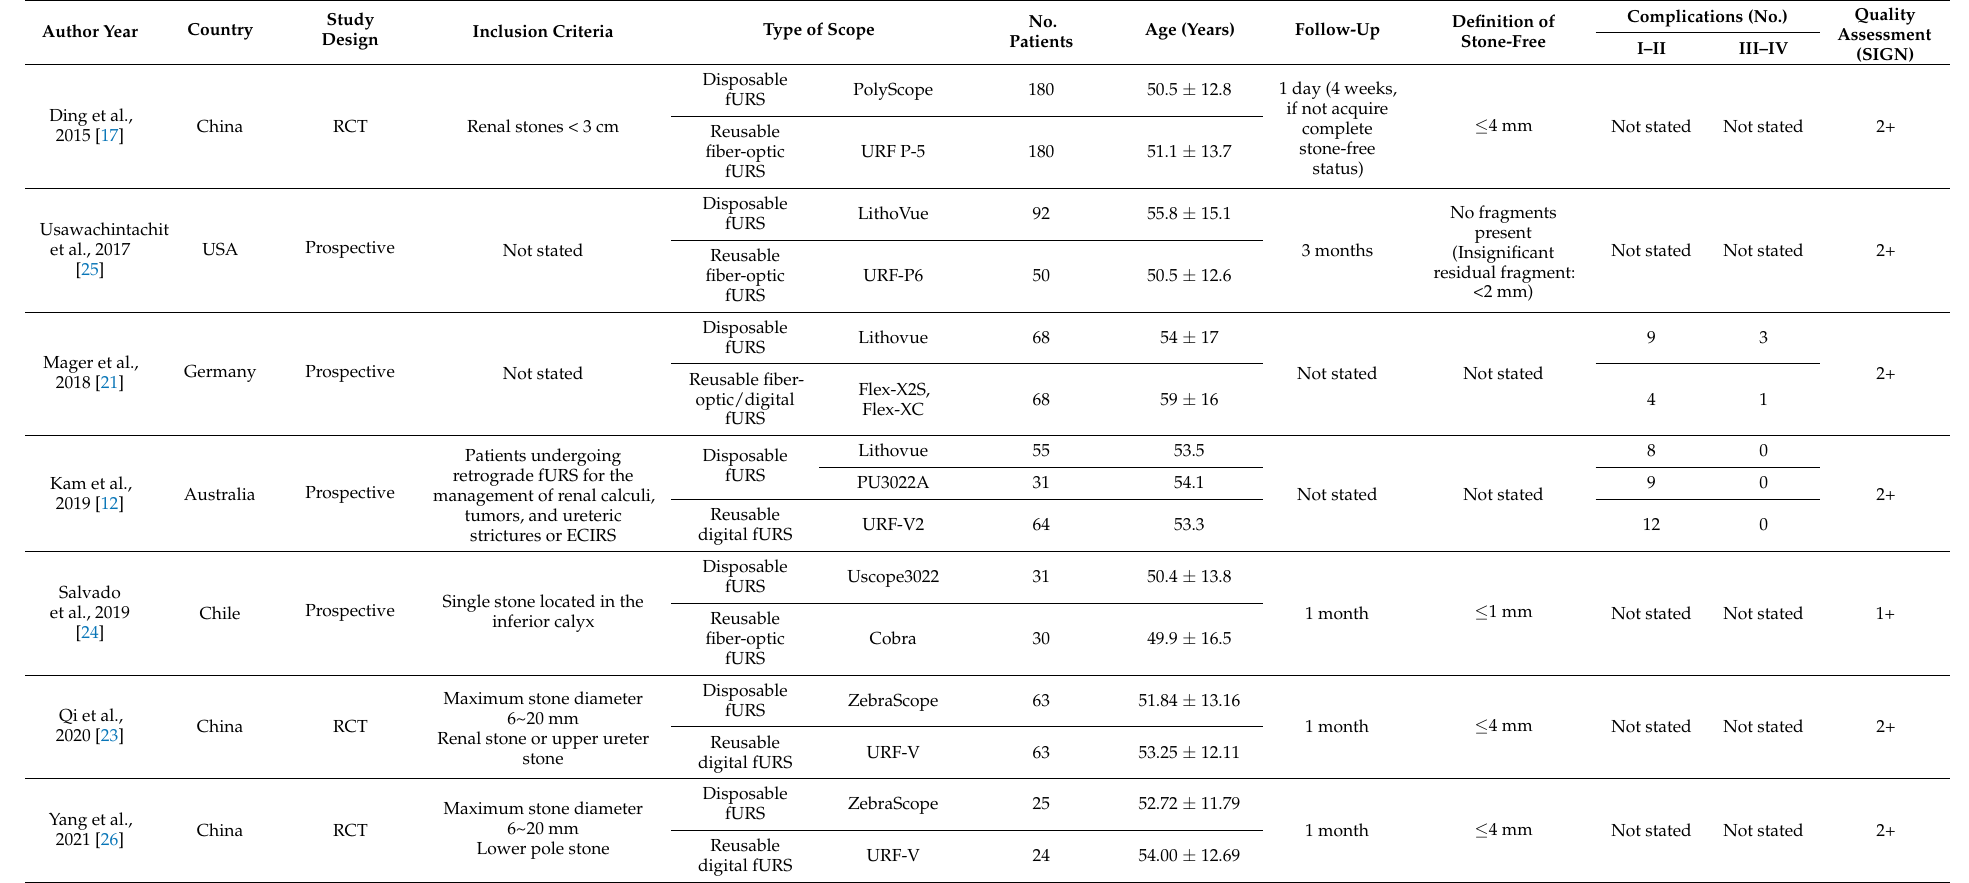
Table 1. Characteristics of the studies included in the